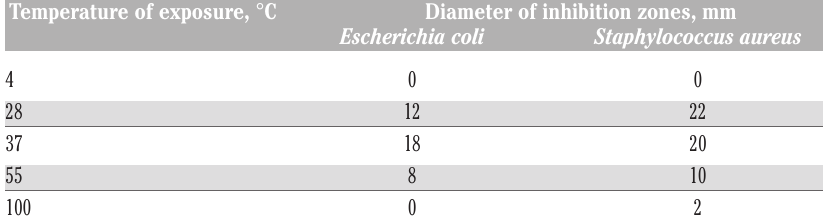
Table 2. Effect of temperature on the bacteriocin stability.